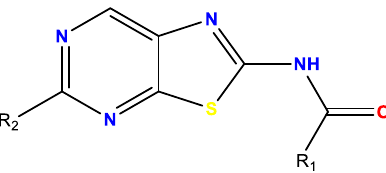
Figure 26. General formula of synthesized compounds.